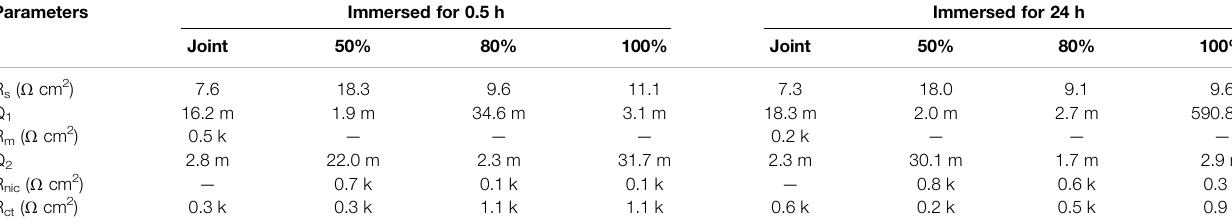
TABLE 3 | The fi tting impedance parameters of samples after 0.5- and 24-h immersion in simulated seawater. Parameters Immersed for 0.5 h Immersed for 24 h